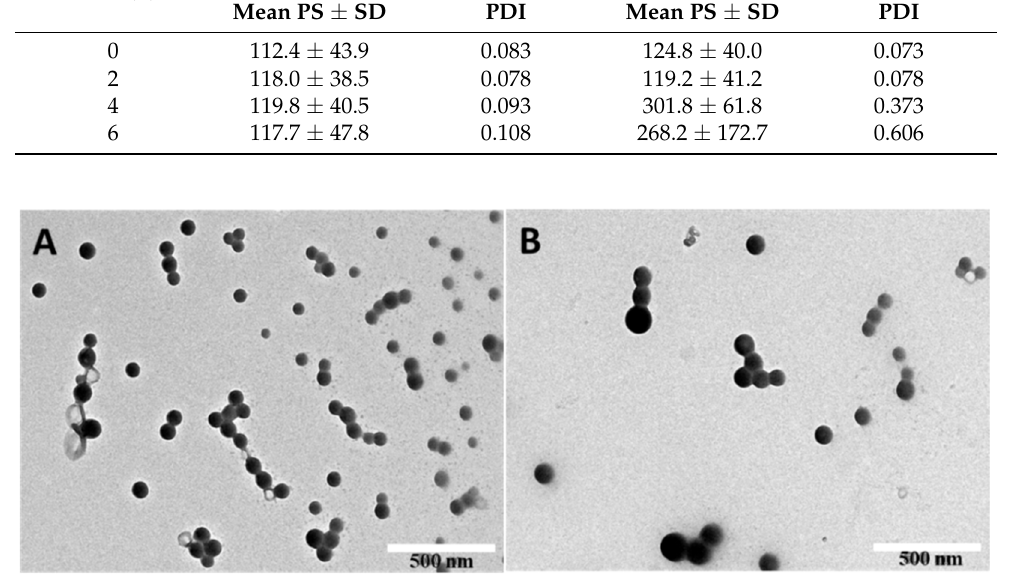
Figure 1. The particle size and morphology of NS. NS ( A ) and NS after one year ( B ) after redispersion by water. Table 1. The stability of NS suspension at different temperatures.